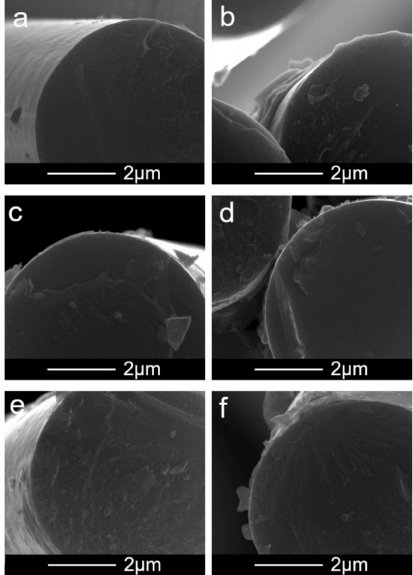
Figure 2. SEM images showing the influence of oxidation / unsheathing on the morphology of CNT layers formed after the EPD process: ( a ) CF before the EPD, ( b ) oxidation time 10 min, ( c ) 15 min, ( d ) 30 min, ( e ) 75 min, ( f ) 90